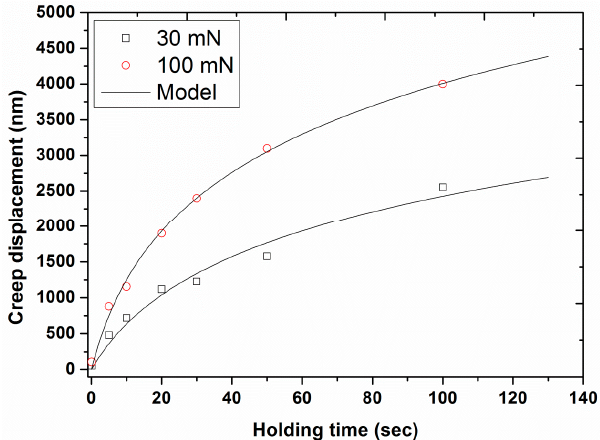
Figure 15. Creep displacement as a function of holding time for the two different peak loads, 30 and 100 mN. The solid line represents model fitting. Table 1. Values of fitting parameters of Equation (1) for UHMWPE.